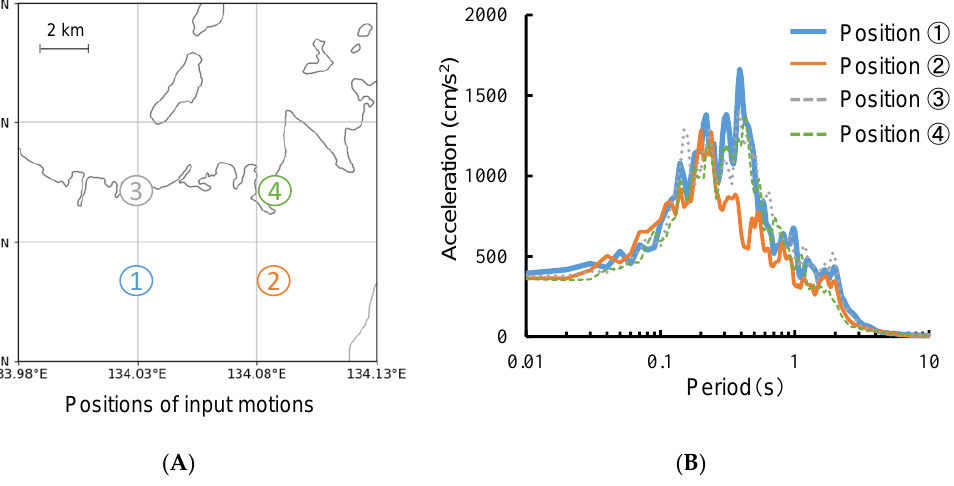
Figure 4. Locations of given input motions and acceleration response spectra at each location. ( A ) Locations of input motions at engineering bedrock. ( B ) Acceleration response spectra of input motions.